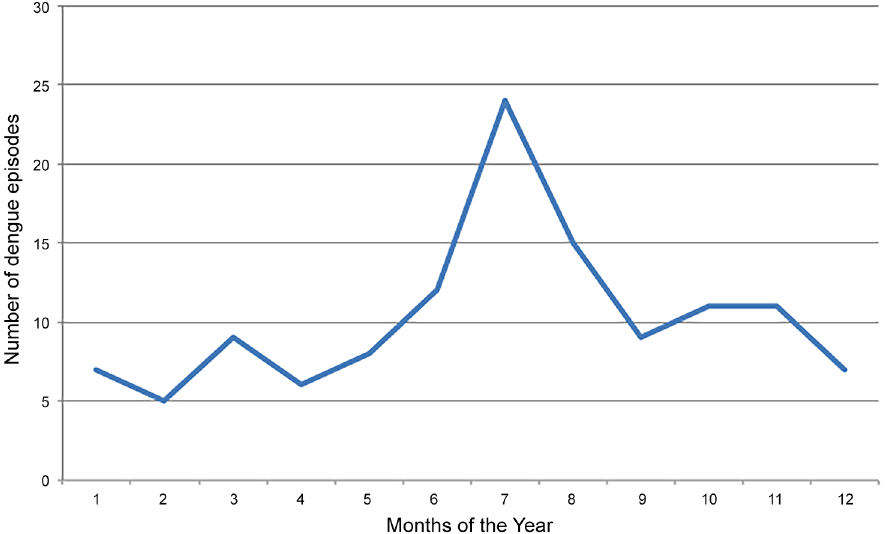
Fig 1. Distribution of the number of clinical dengue episodes over the months of the year during the RV144 trial between July 2004 and November